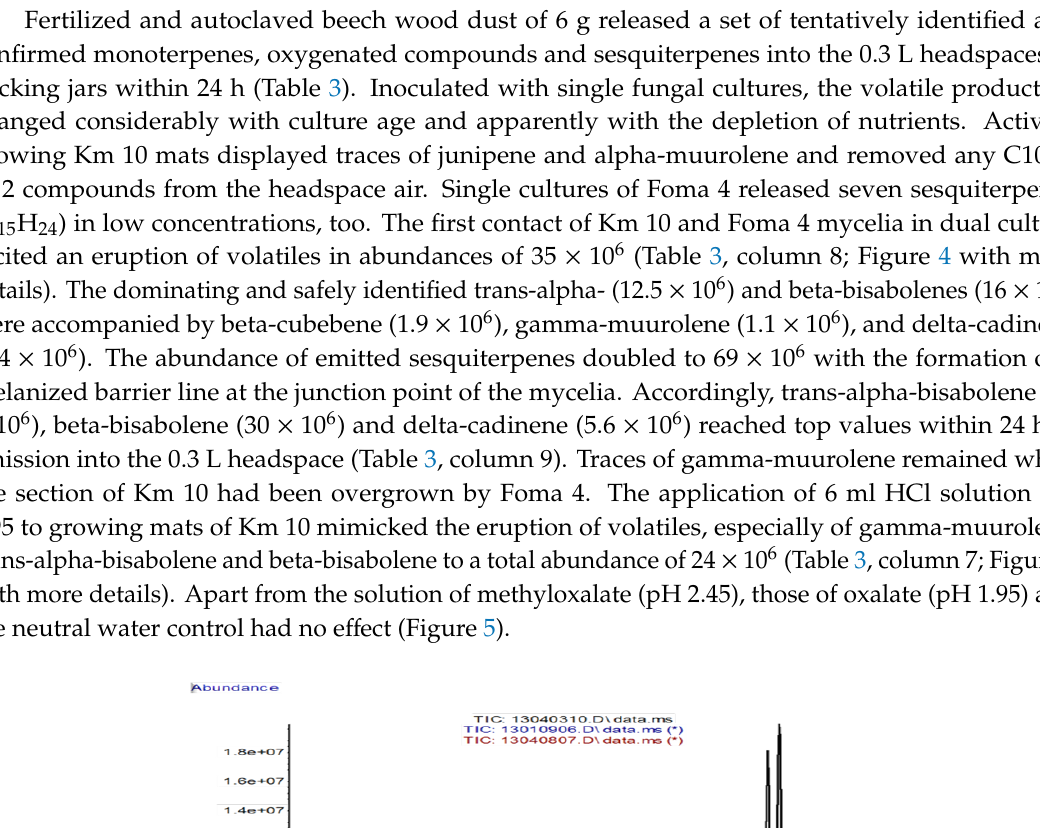
Table 2. Colonization of oxalate amended beech wood samples by agar mycelia of K. mutabilis Km